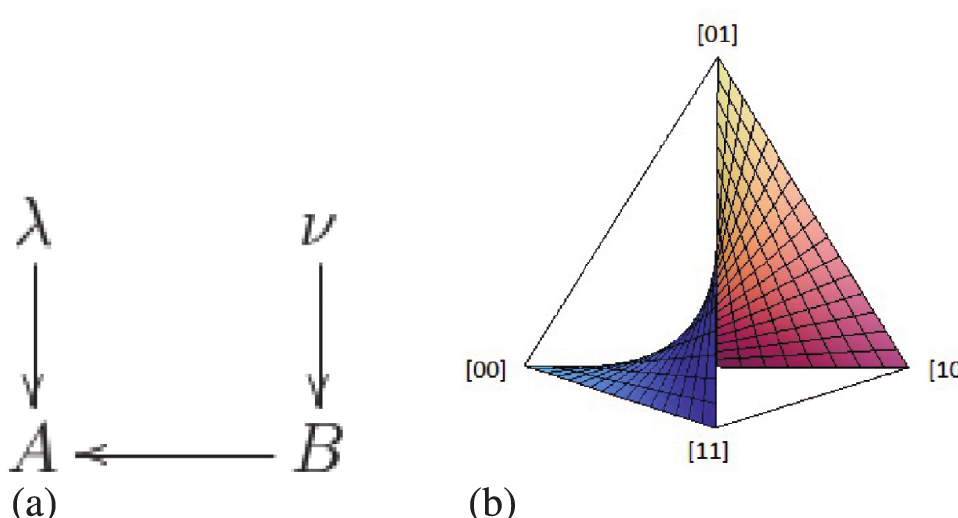
Figure 1: (a) DAG for causal model defined by u = u ⊕ u and u = u (b) Joint distributions that can be generated by this causal